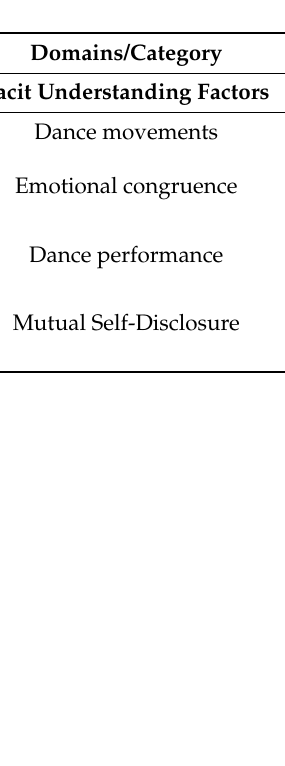
Table 7. Domains and categories.